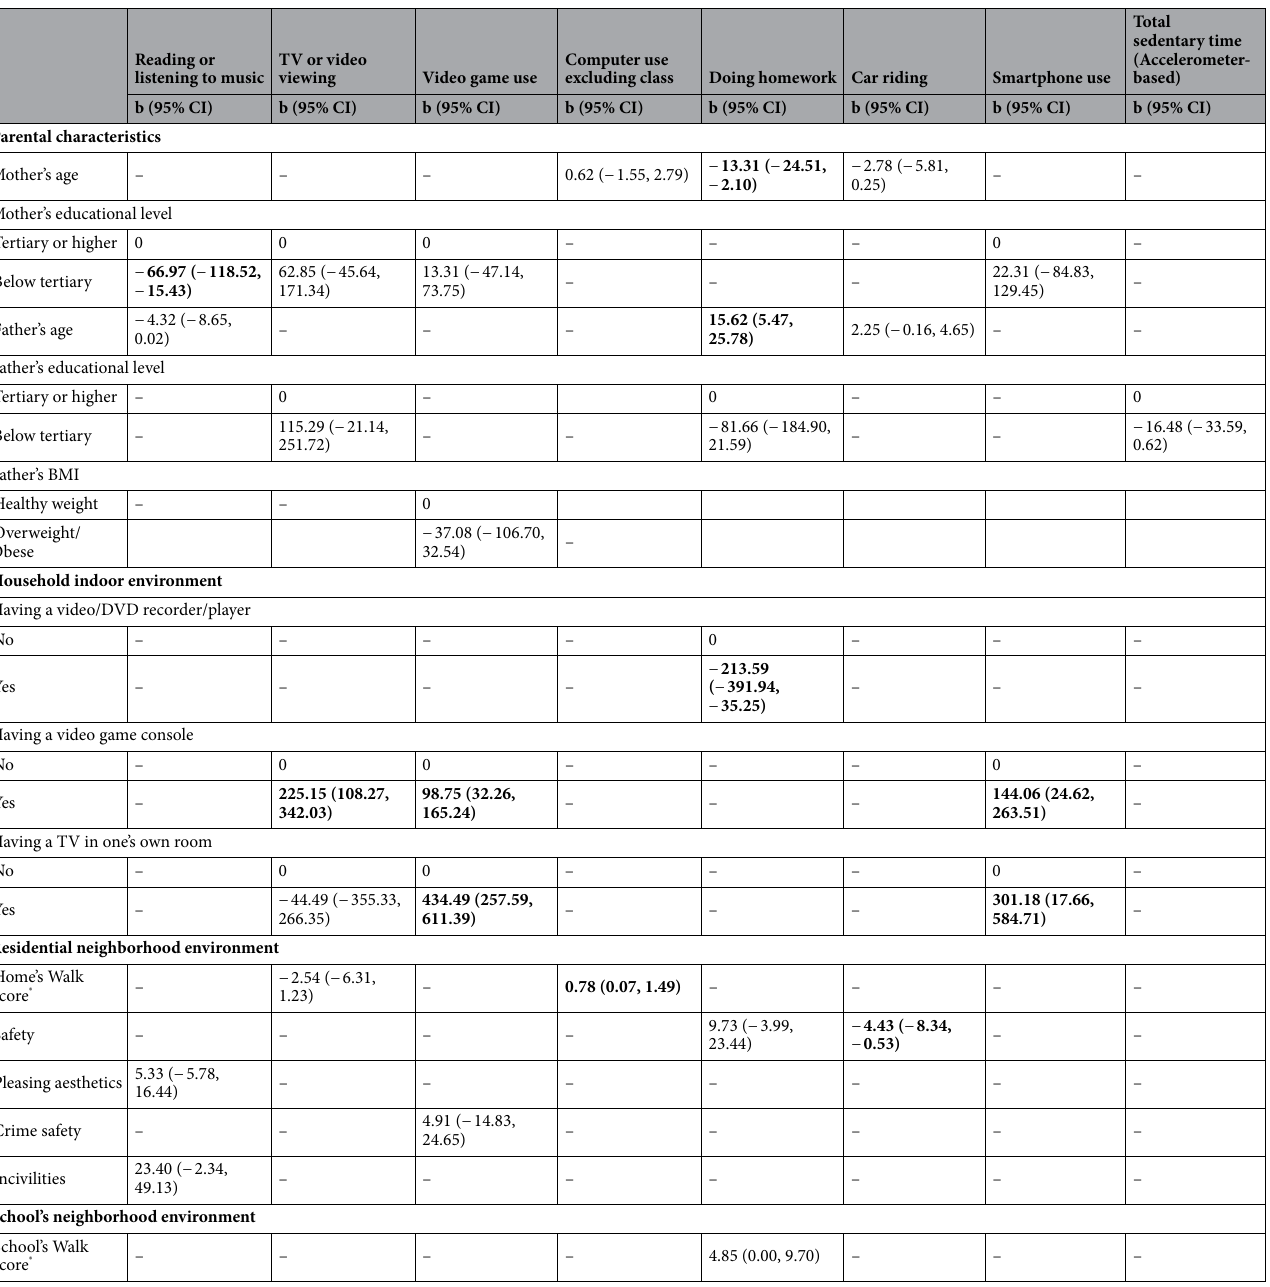
Table 3. Fully adjusted regression models for correlates of domain− specific sedentary behaviors and objectively assessed sedentary time among children. b = unstandardized regression coefficients; CI = confidence interval. All models adjusted for children’s age, sex, BMI, annual household income, and locality. Bolded data indicate significance ( p <